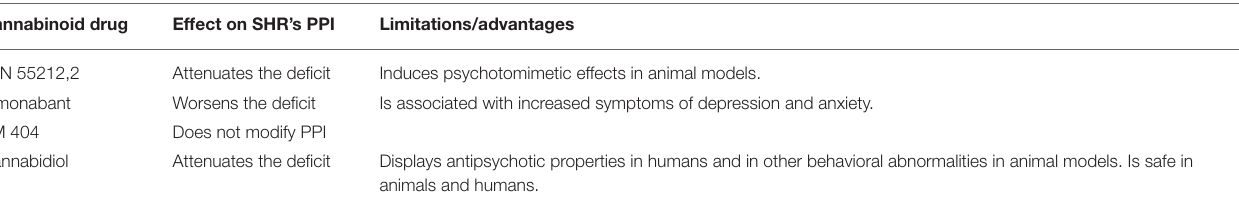
TABLE 1 | Cannabinoid drugs as potential agents to treat prepulse inhibition of startle (PPI) deficits in schizophrenia. Cannabinoid drug Effect on SHR’s